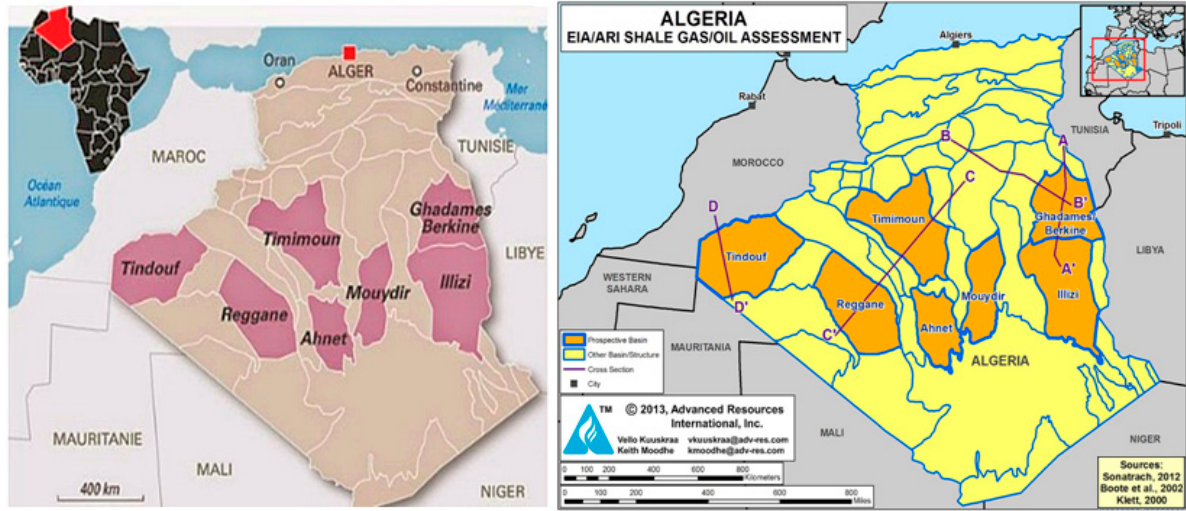
Figure 5. Shale gas basins of Algeria [34].